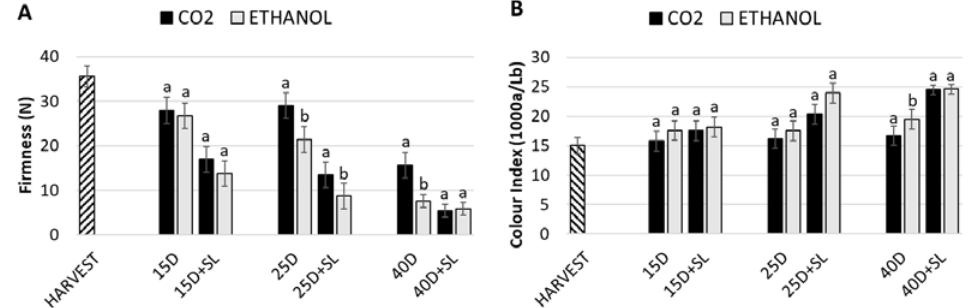
Figure 3. Changes in the ( A ) firmness and ( B ) external colour of the ‘Giombo’ persimmon treated with CO 2 or ethanol after cold storage (1 °C) and after shelf-life simulation (5 more days at 20 °C). D: Days of cold storage; SL: Shelf-life simulation. The vertical bar represents the least significant difference (LSD) intervals ( p ≤ 0.05) (interaction treatment–storage days). Different letters above bars indicate significant differences between treatments at each moment of evaluation ( p ≤ 0.05).